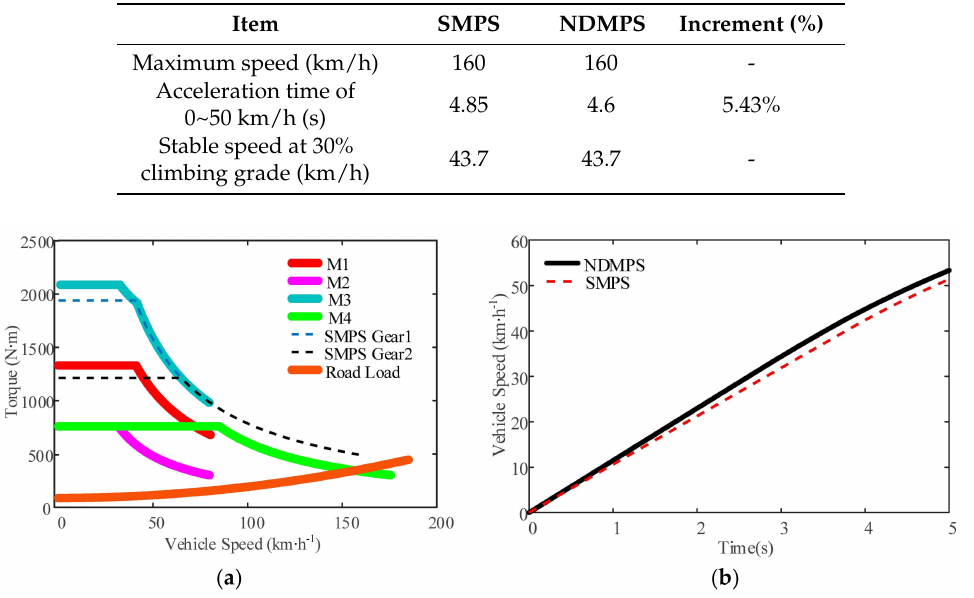
Figure 9. Dynamics simulation for the SMPS and NDMPS. ( a ) External characteristics of the driving system; ( b ) Acceleration